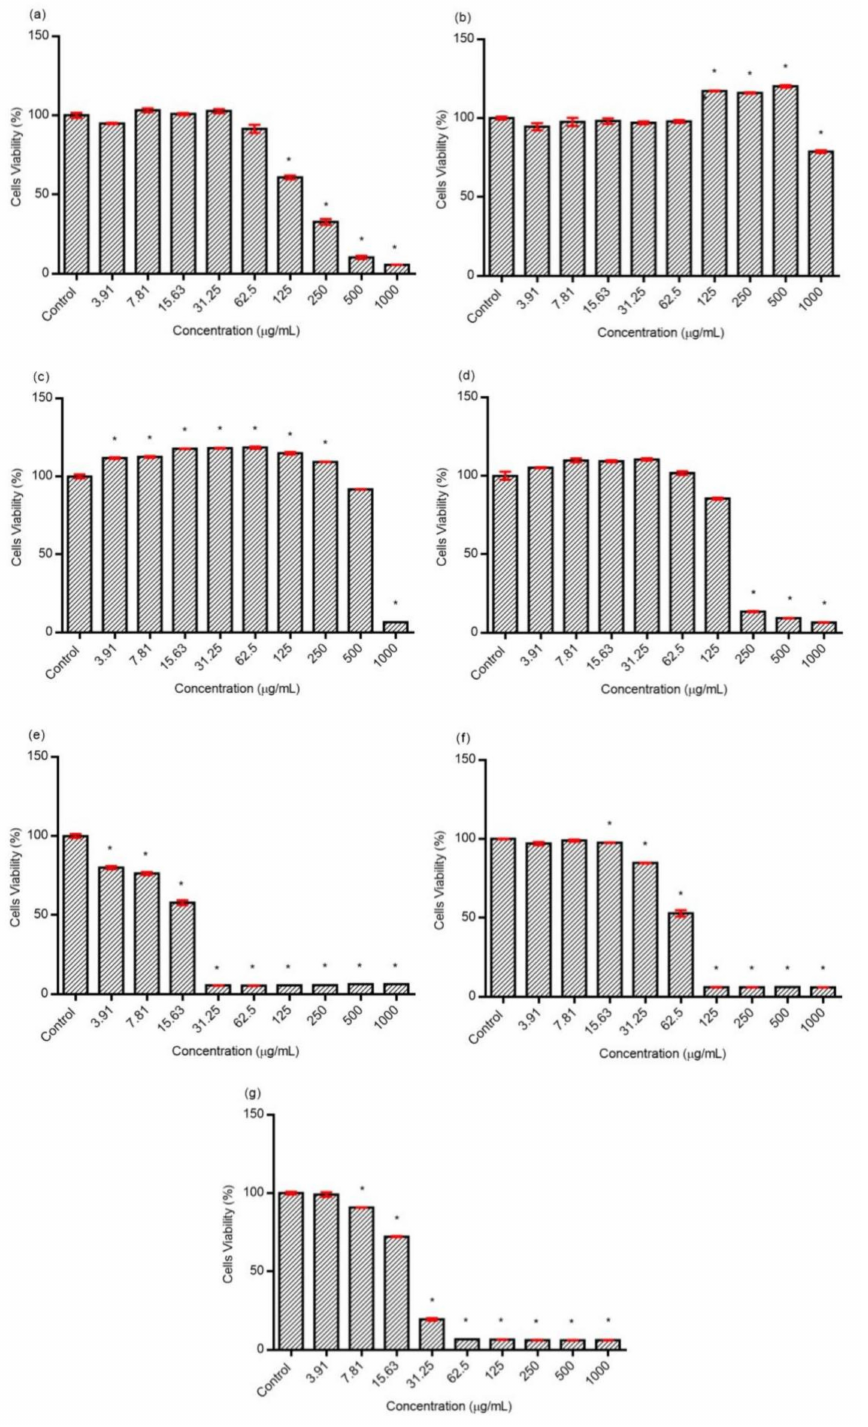
Figure 9. Cytotoxicity analysis of OS and its fractions on the HSF 1184 cell line after 24 h of treatment. ( a ) Crude extract, ( b ) F1, ( c ) F2, ( d ), F3, ( e ) F4, ( f ) F5, and ( g ) F6. The data represent the mean ± SD of three experiments. * represents significant results ( p < 0.05) compared with the control (untreated HSF 1184